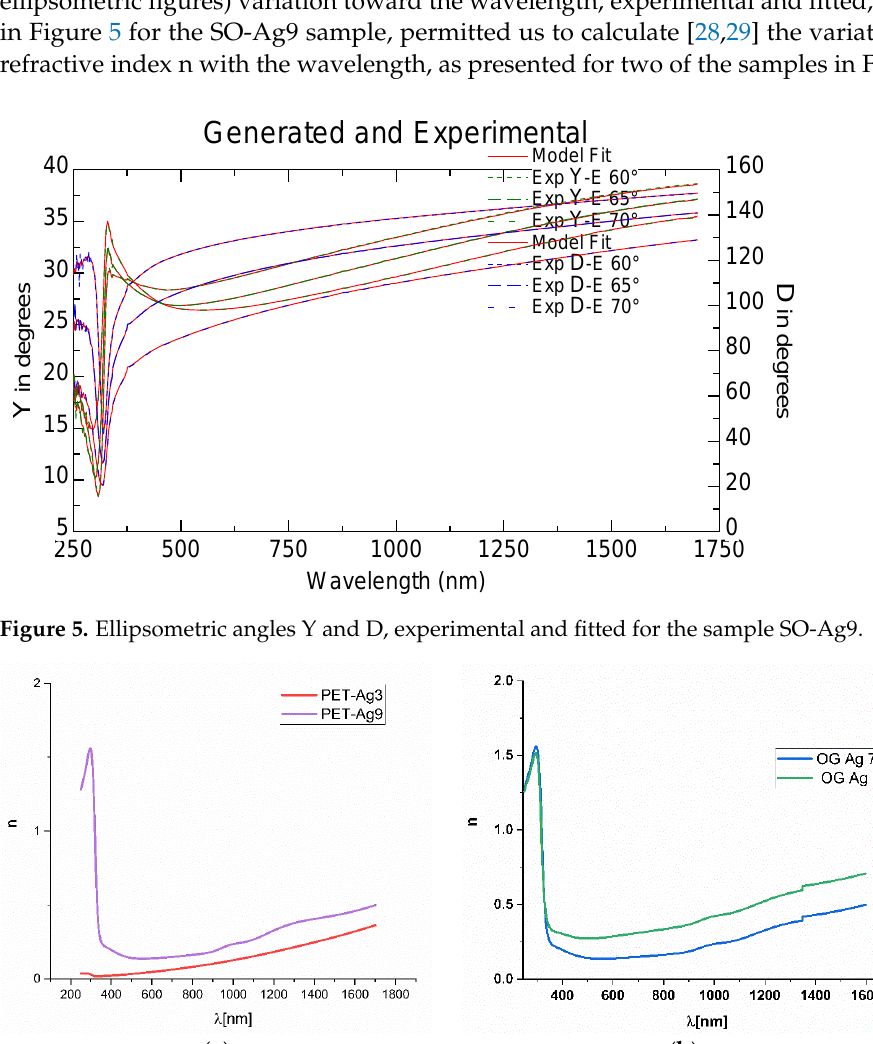
Inorganics 2022 , 10 , x FOR PEER REVIEW